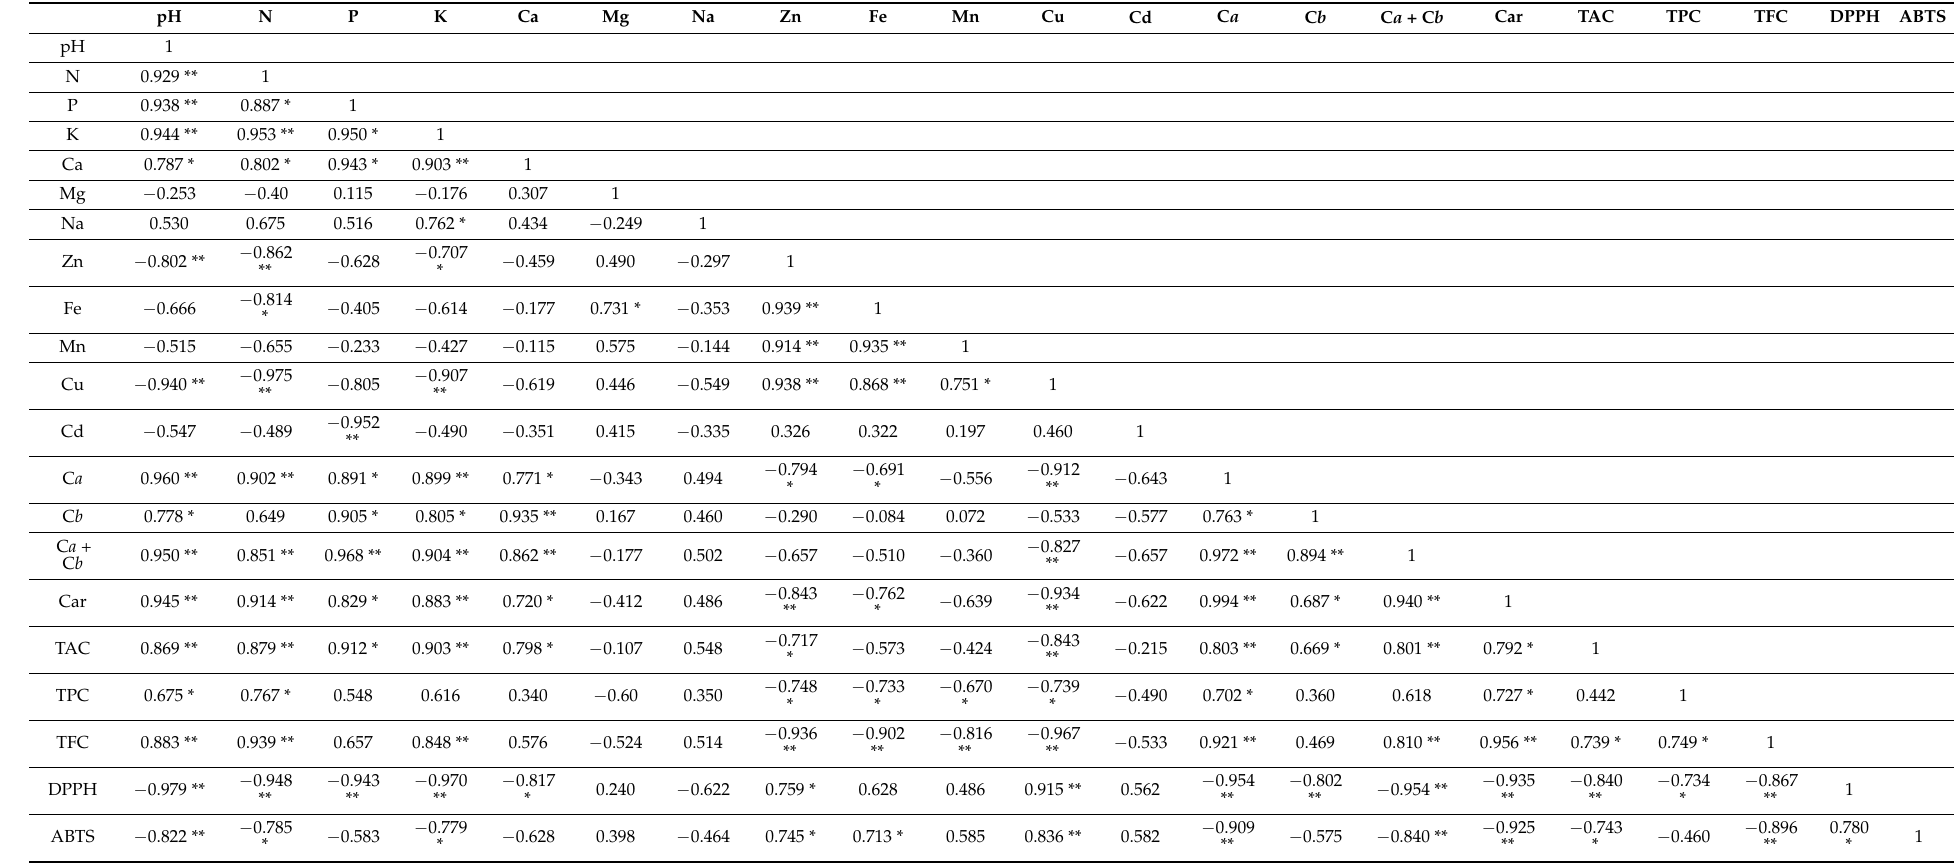
Table 6. Significant Pearson’s Correlation between